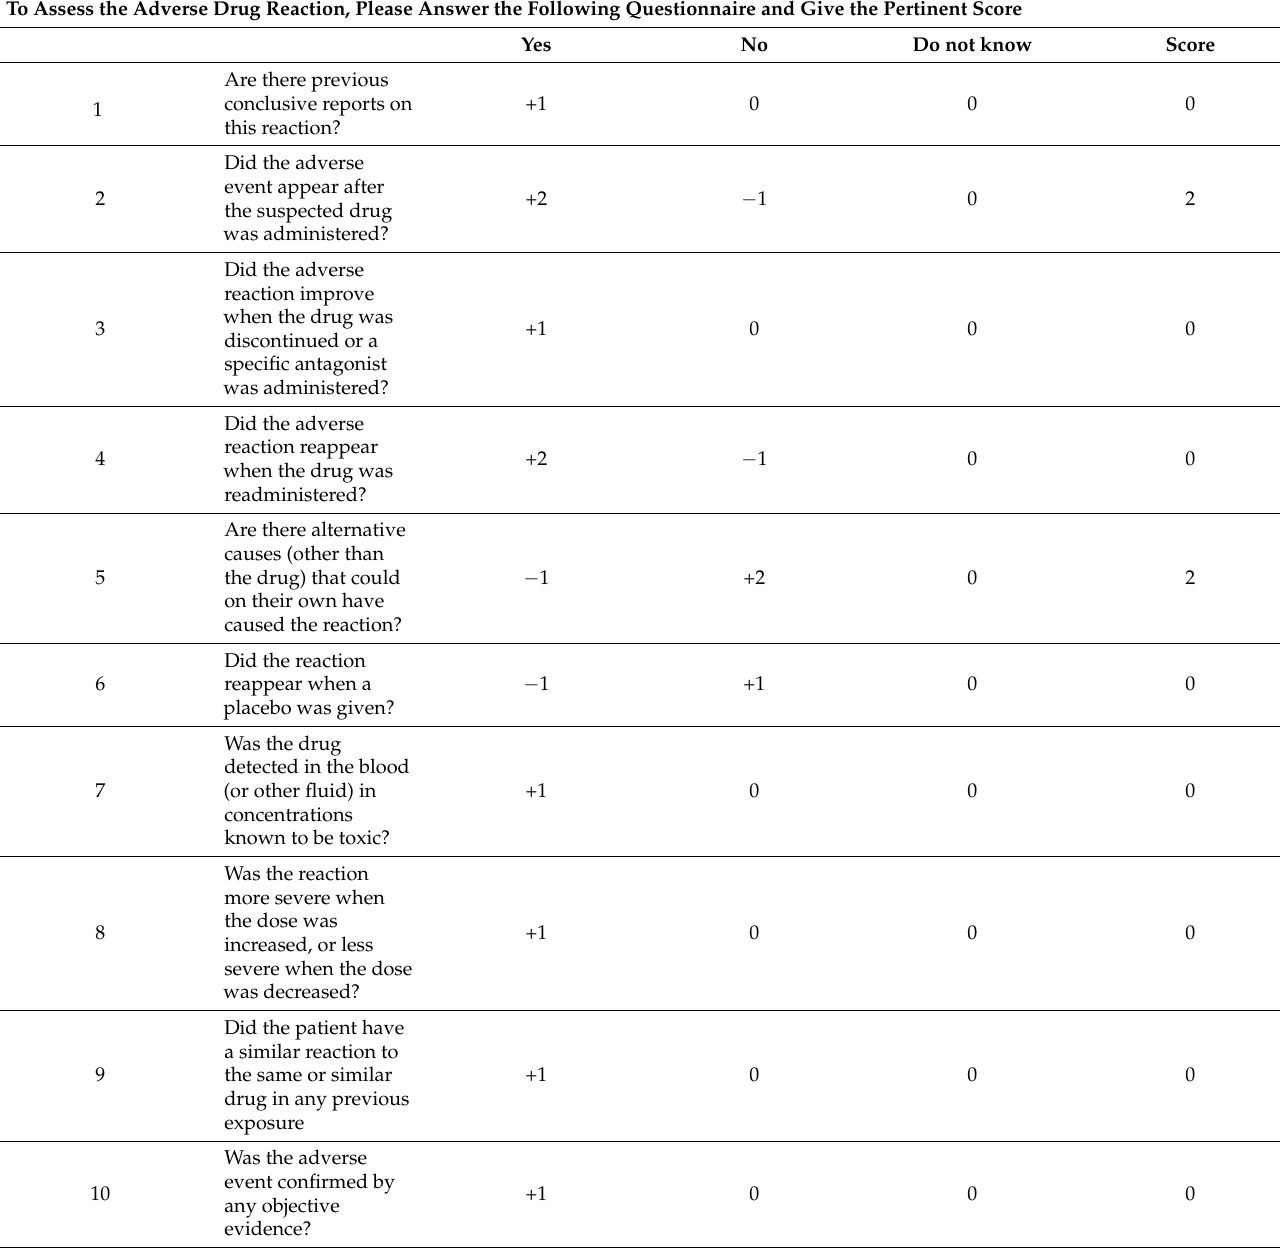
Table 1. Naranjo adverse drug reaction (ADR) probability